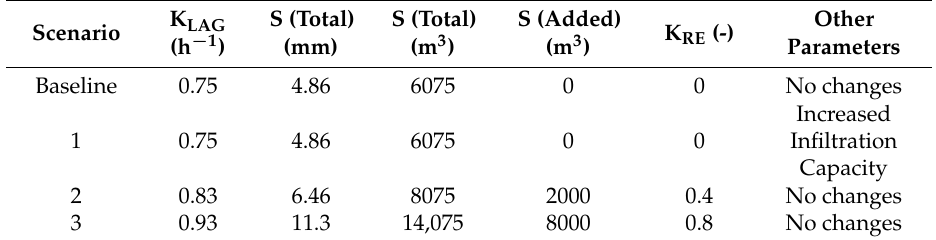
Table 2. Details of the scenarios modelled in the NBC: parameter Values and storages (S). Baseline values are shown for